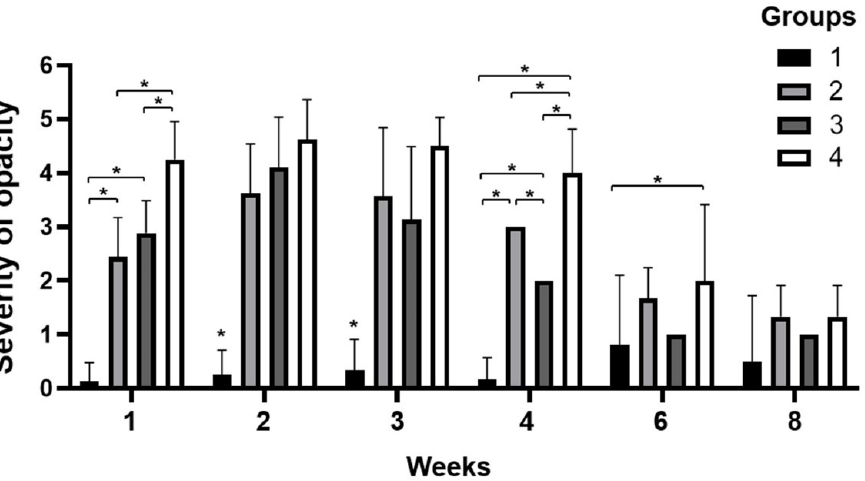
Figure 4. Severity of corneal opacity score was evaluated. In the first week, the opacity of group 4 was higher than that of the other groups. In the second week, the opacity of all groups except group 1 was increased. Although the opacity was decreased at 4 and 6 weeks, the opacity of group 4 was higher than that of the other groups. After six weeks, opacity was greatly reduced in all groups. The number of samples in each group is indicated in Table S2 *, p ≤ 0.05.